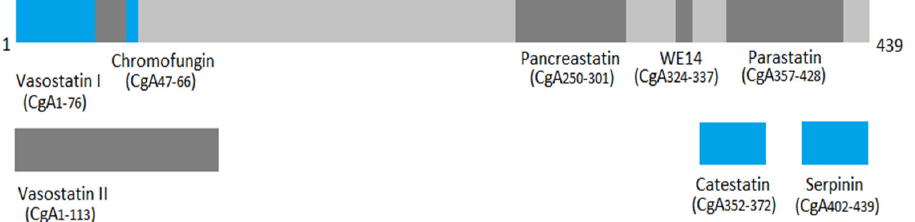
Figure 1. Chromogranin A and its most important biologically active peptides [6,21]. The blue color is reserved for the peptides with the highest significance regarding the discussed issue; light grey represents the whole CgA protein; dark gray rest of the marked peptides.